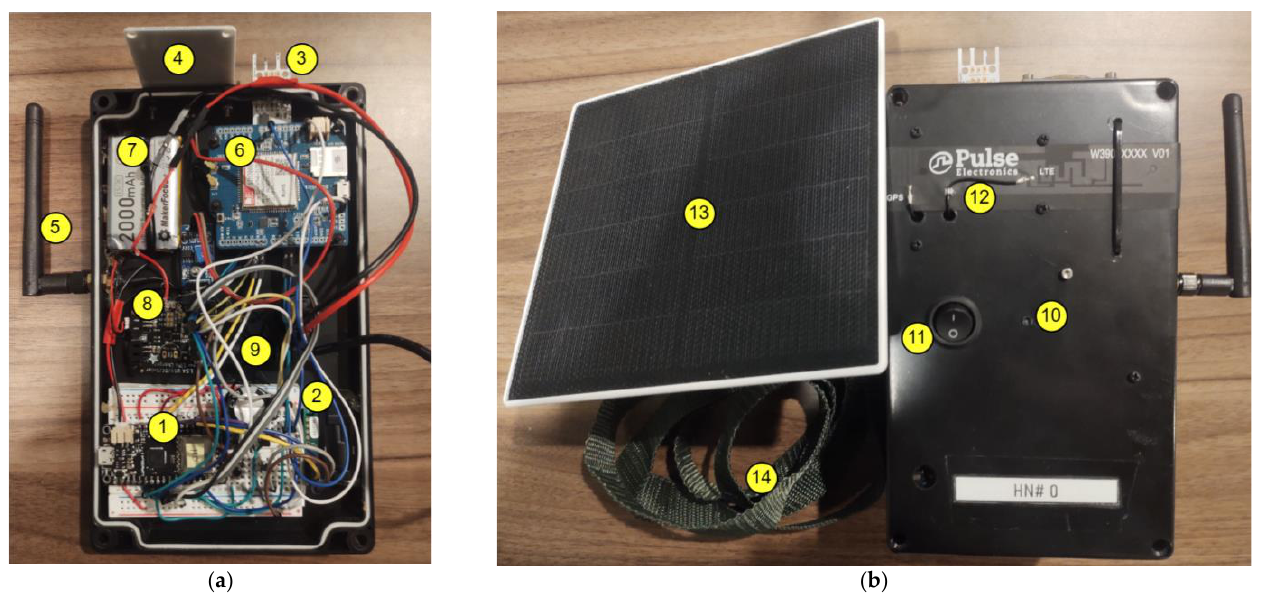
Figure 11. Photograph of the hub node: ( a ) bottom view of the front cover — (1) LoRa32u4 II devel- opment board, (2) SCD30 module containing temperature, humidity, and CO 2 sensors, (3) wind speed sensor, (4) rain sensor, (5) LoRa antenna, (6) LTE modem, (7) battery, (8) charger module, (9) solar panel connector; ( b ) top view of the hub node — (10) heartbeat LED, (11) power switch, (12) LTE flexible antenna, (13) solar panel, (14) belt for hanging.